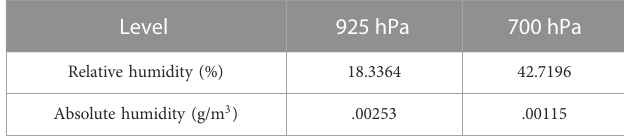
TABLE 2 Comparison of relative and absolute humidity at the 925 hPa and 700 hPa